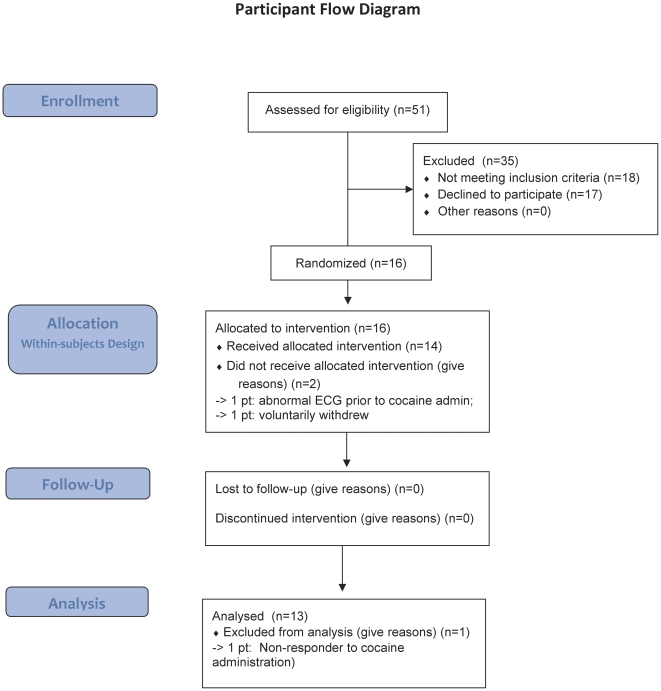
CONSORT Flowchart.Participant flowchart.